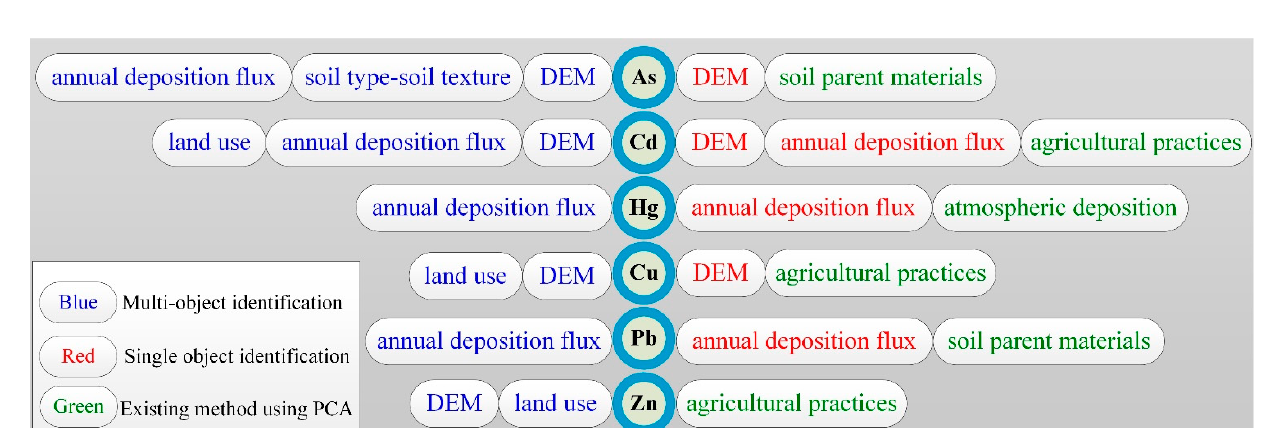
Figure 8. The identification results for this study and the related study I [17].